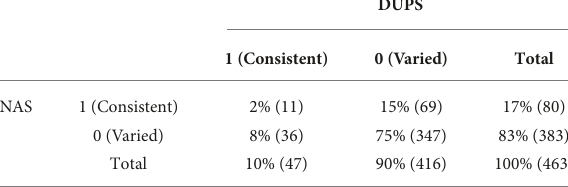
TABLE 3 Response consistency between DUPS and NAS total scores.